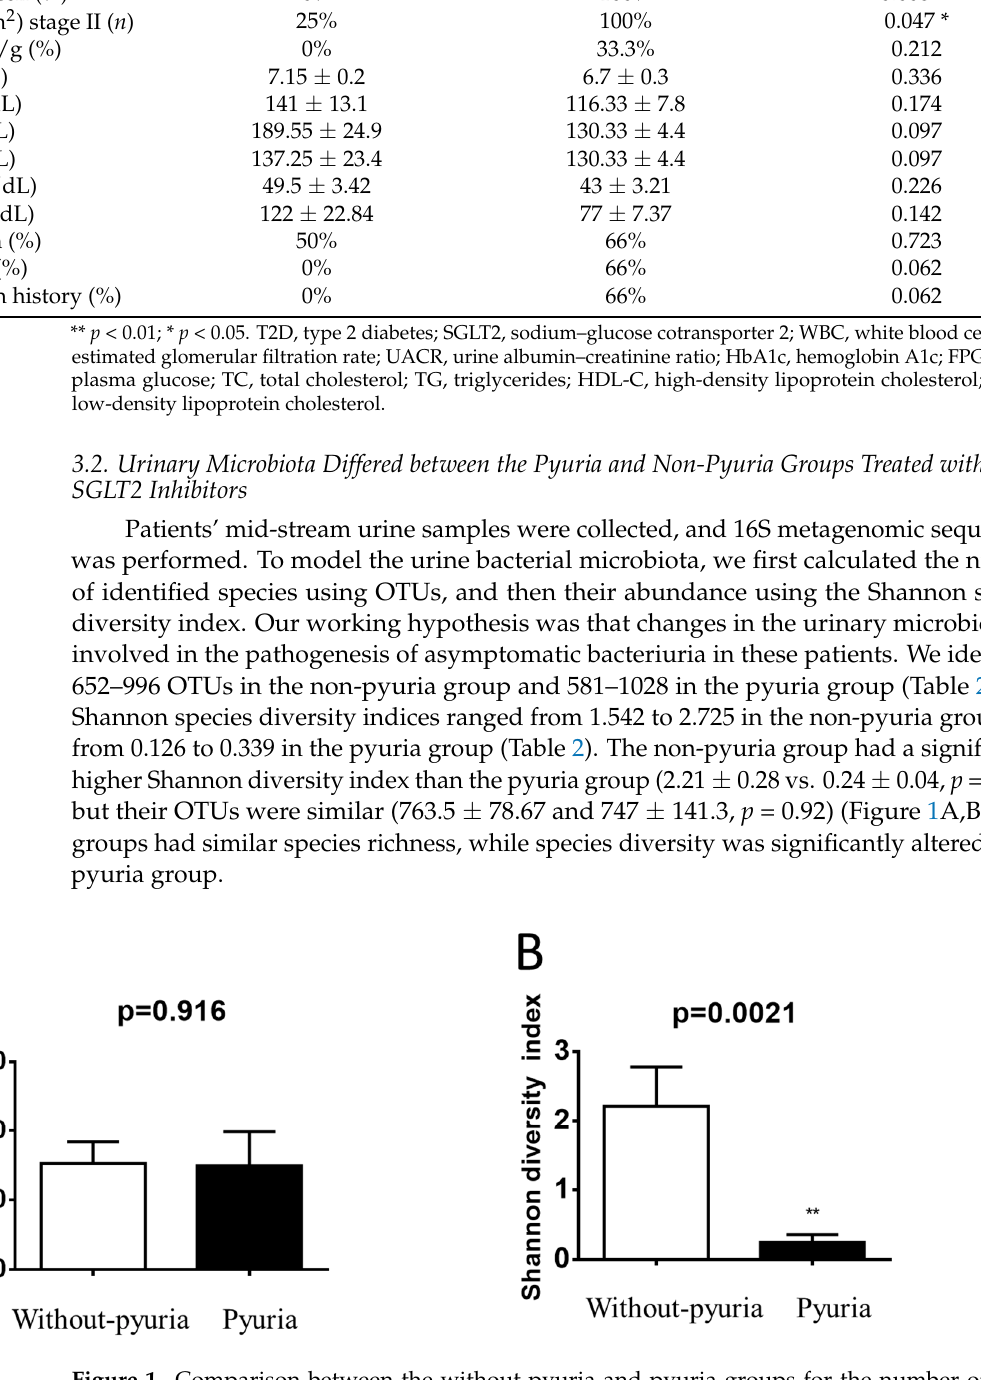
Figure 1. Comparison between the without-pyuria and pyuria groups for the number of OTUs ( A ) and the Shannon diversity index ( B ) in T2D patients treated with SGLT2 inhibitor. ** p < 0.01.